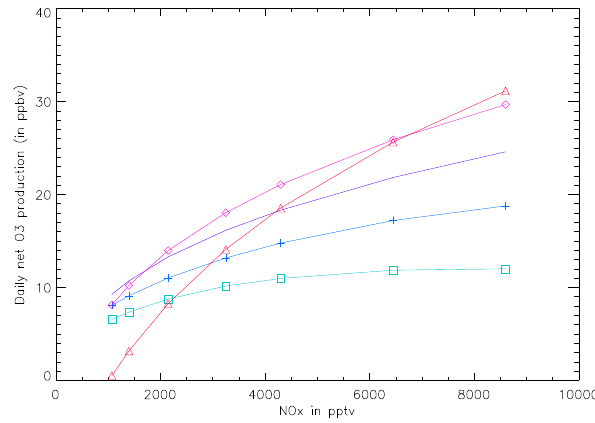
Fig. 12. Daily net O 3 production simulated by the box model as a function of NO x for different VOC initialisations: green line with squares (VOC/4), blue line with crosses (VOC/2), purple line (reference VOC), pink line with diamonds (VOCx2) and red line with triangles (VOCx4).